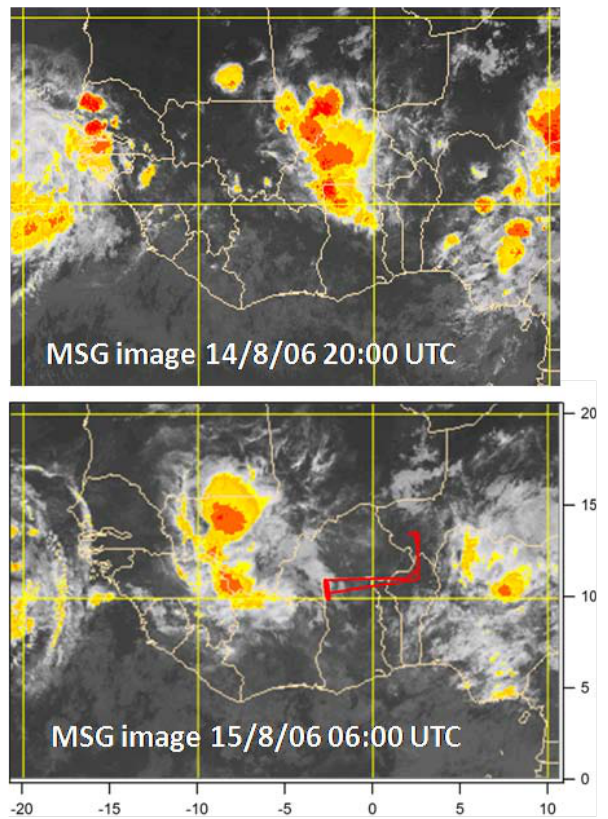
Fig. 3. The MSG satellite image below shows IR brightness temper- ature (top) when the southern edge of an MCS line associated with the African Easterly Wave crest passed over NW Ghana and (bot- tom) the cloud deck trailing behind system the following morning, sampled by FAAM (B233 flight track in